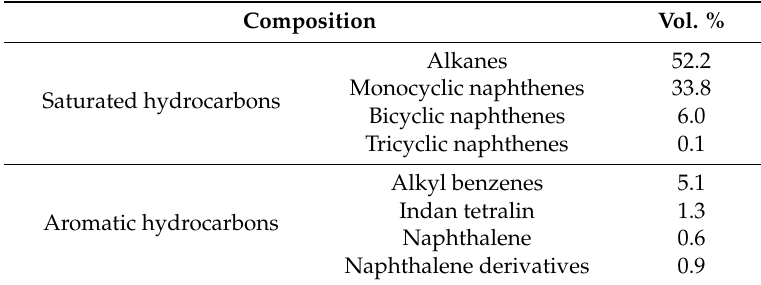
Table 1. Compositions of Chinese No.3 jet fuel (RP-3 kerosene). Composition Vol. % Alkanes 52.2 Monocyclic naphthenes Saturated hydrocarbons